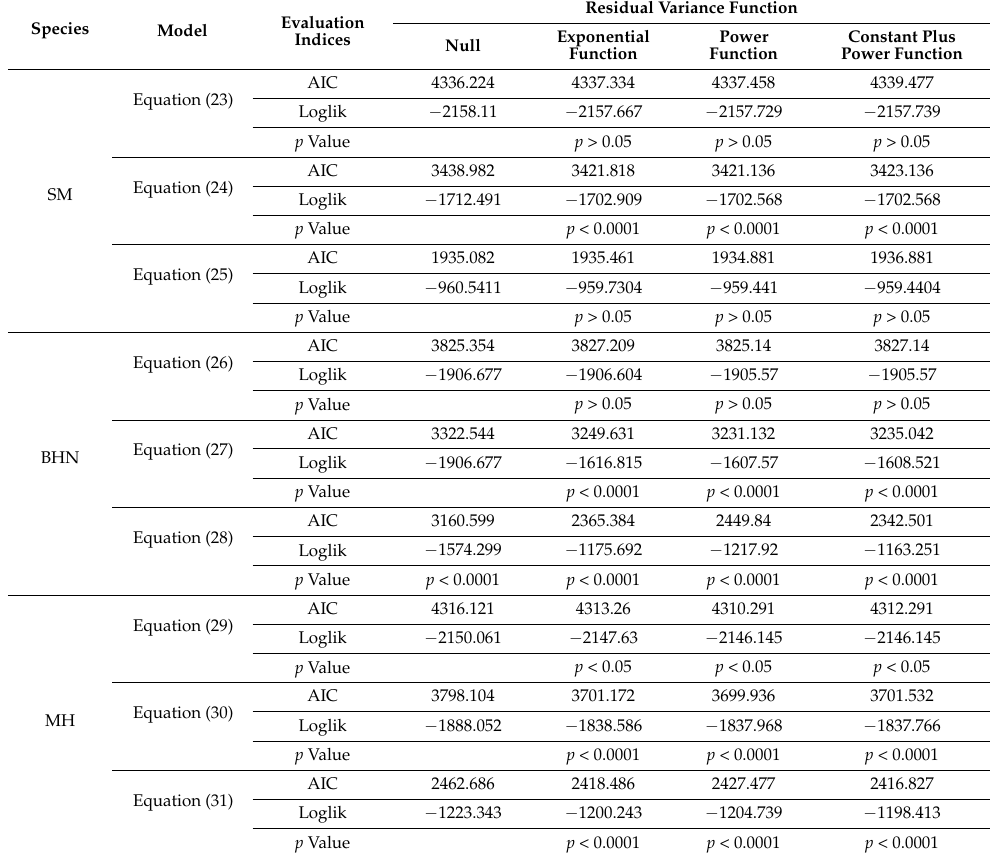
Table 3. Performance of mixed-effect model Equations (23)–(31) using morphological data with different variance functions. SM, BHN, and MH represent Cunninghamia lanceolata , Machilus pauhoi , and Schima superba ,